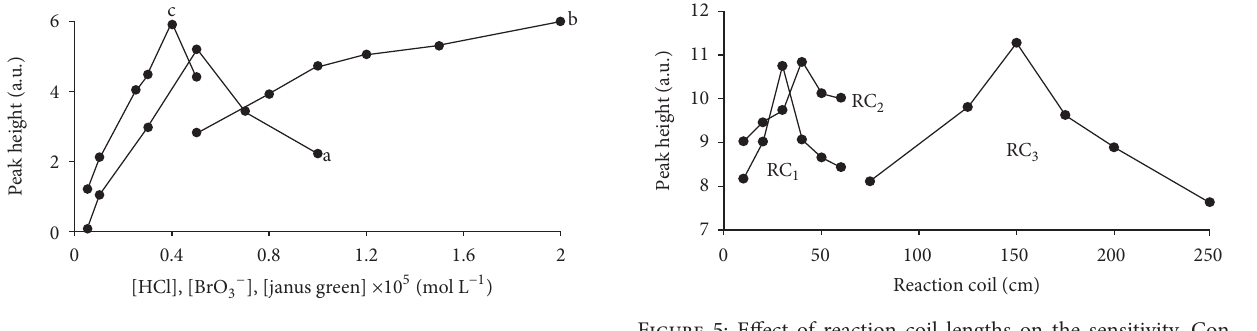
F 5: Effect of reaction coil lengths on the sensitivity. Con- ditions: 0.5M hydrochloric acid, 2